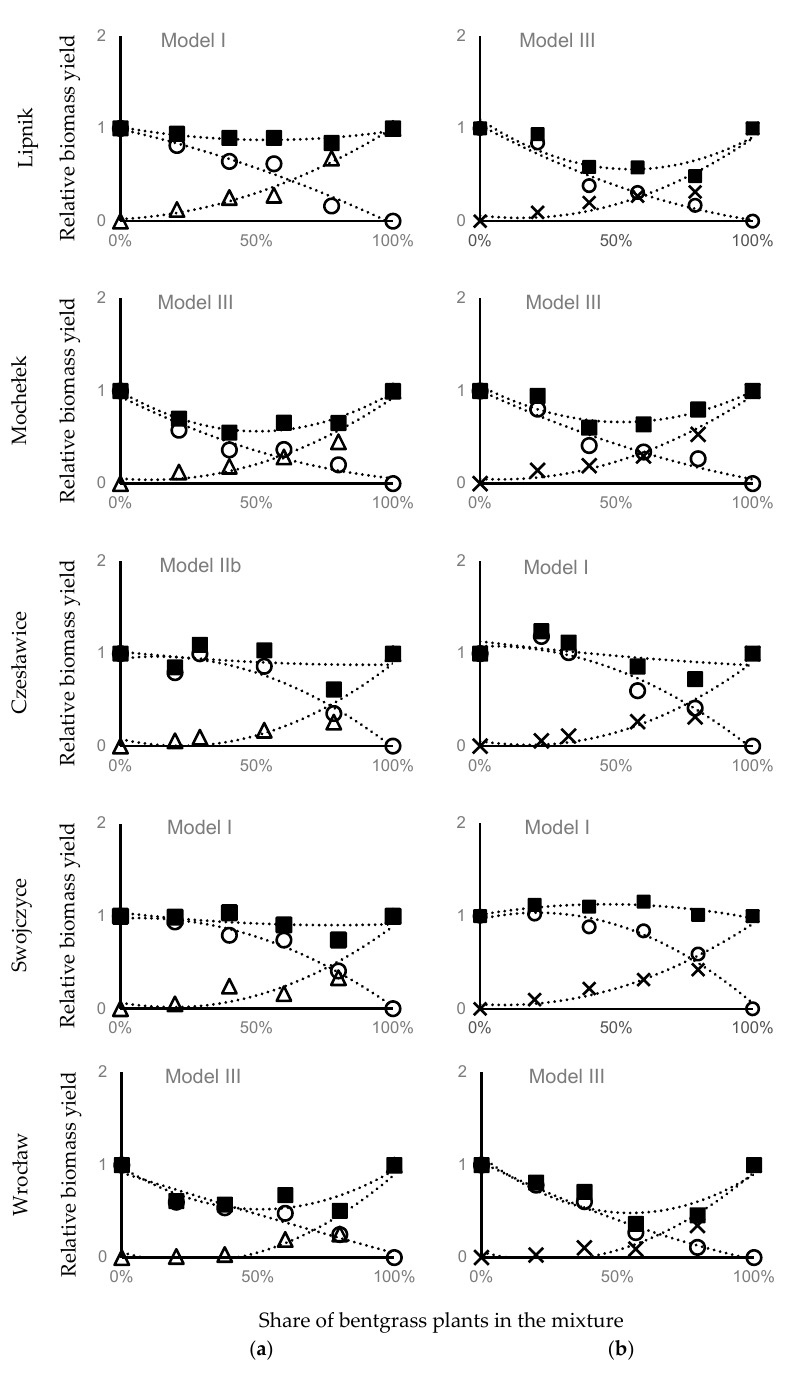
Figure 2. The substitutive competition model for the relative biomass yield of winter wheat (WW) and bentgrass in the 2017–2018 season, classified according to the t-test and p -values < 0.05. ( a ) Competition between WW and bentgrass with a single resistance to piroxulam (RS), and ( b ) competition between WW and herbicide-susceptible bentgrass (S). Legend: ○ — WW; Δ —RS; ×—S; □ — RS + WW ( a ) or S + WW ( b ).